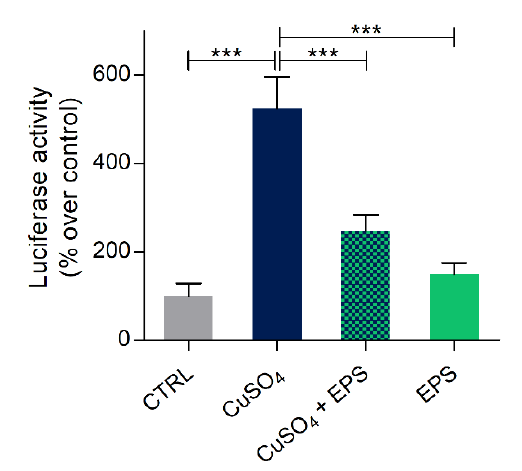
Figure 5. Anti-inflammatory e ff ects of Phormidium EPS after copper induced inflammation in zebrafish larvae. Recovery from inflammation was analyzed with the zebrafish transgenic line NF κ B:GFP,Luc. The data represent the mean ± SEM of three independent experiments conducted with 12–15 larvae. Statistical analysis was performed using GraphPad Prism 7 (one-way ANOVA followed by Tukey’s multiple comparison test). Statistical significance: *** p ≤ 0.001.